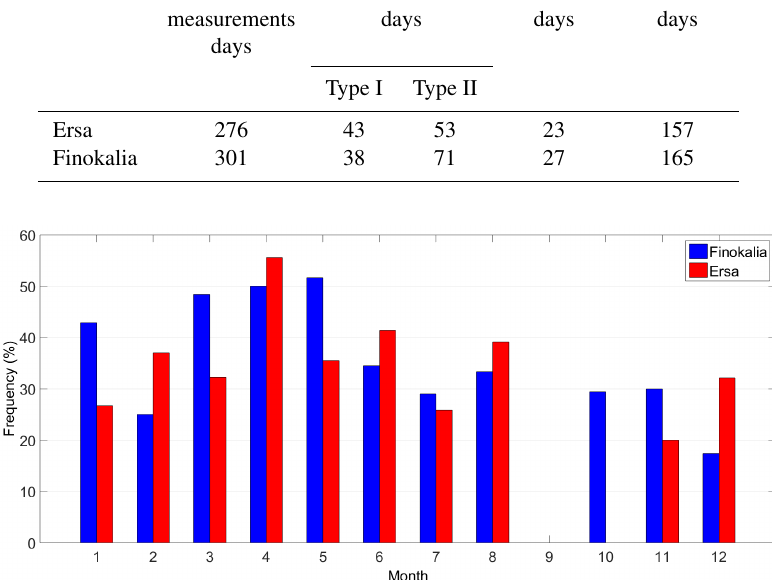
Figure 2. Monthly mean NPF frequencies at Finokalia and Ersa.